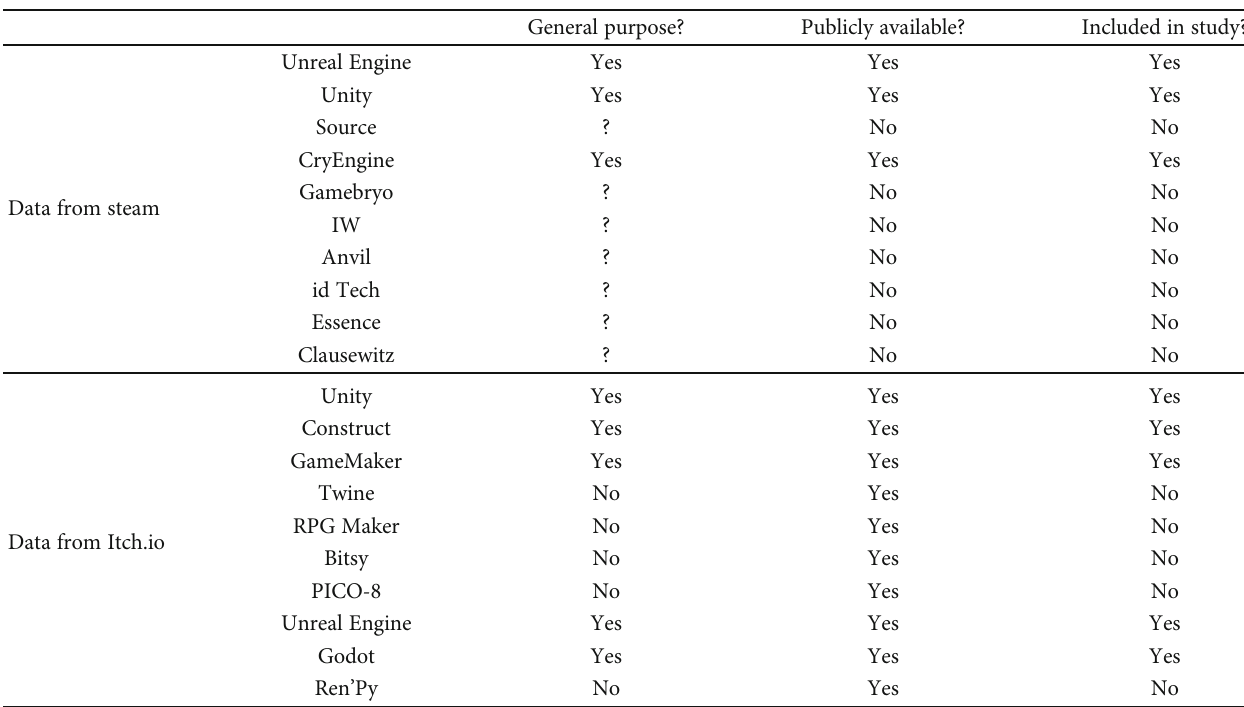
Table 1: Game engines and their inclusion